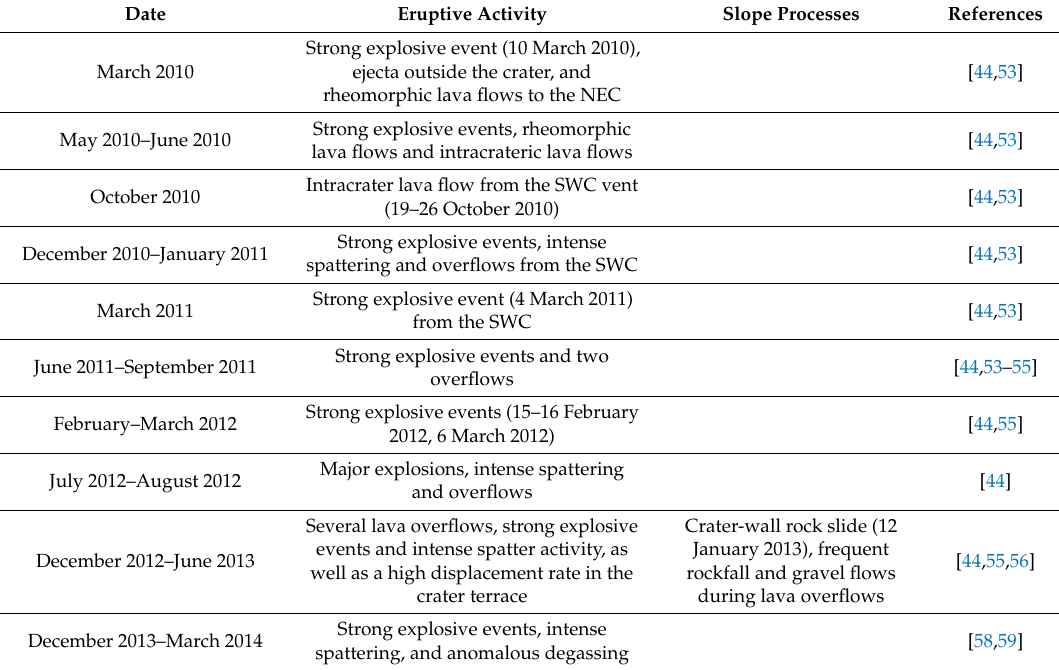
Figure 1. ( a ) Geographic location of the Aeolian Islands (image collected by SENTINEL-3 on 19 July 2018); ( b ) PL É IADES-1B image (1 September 2018) of Stromboli Island. The main geographic and geological features are reported. Table 1. Summary of the eruptive activity at Stromboli volcano from 2010 to